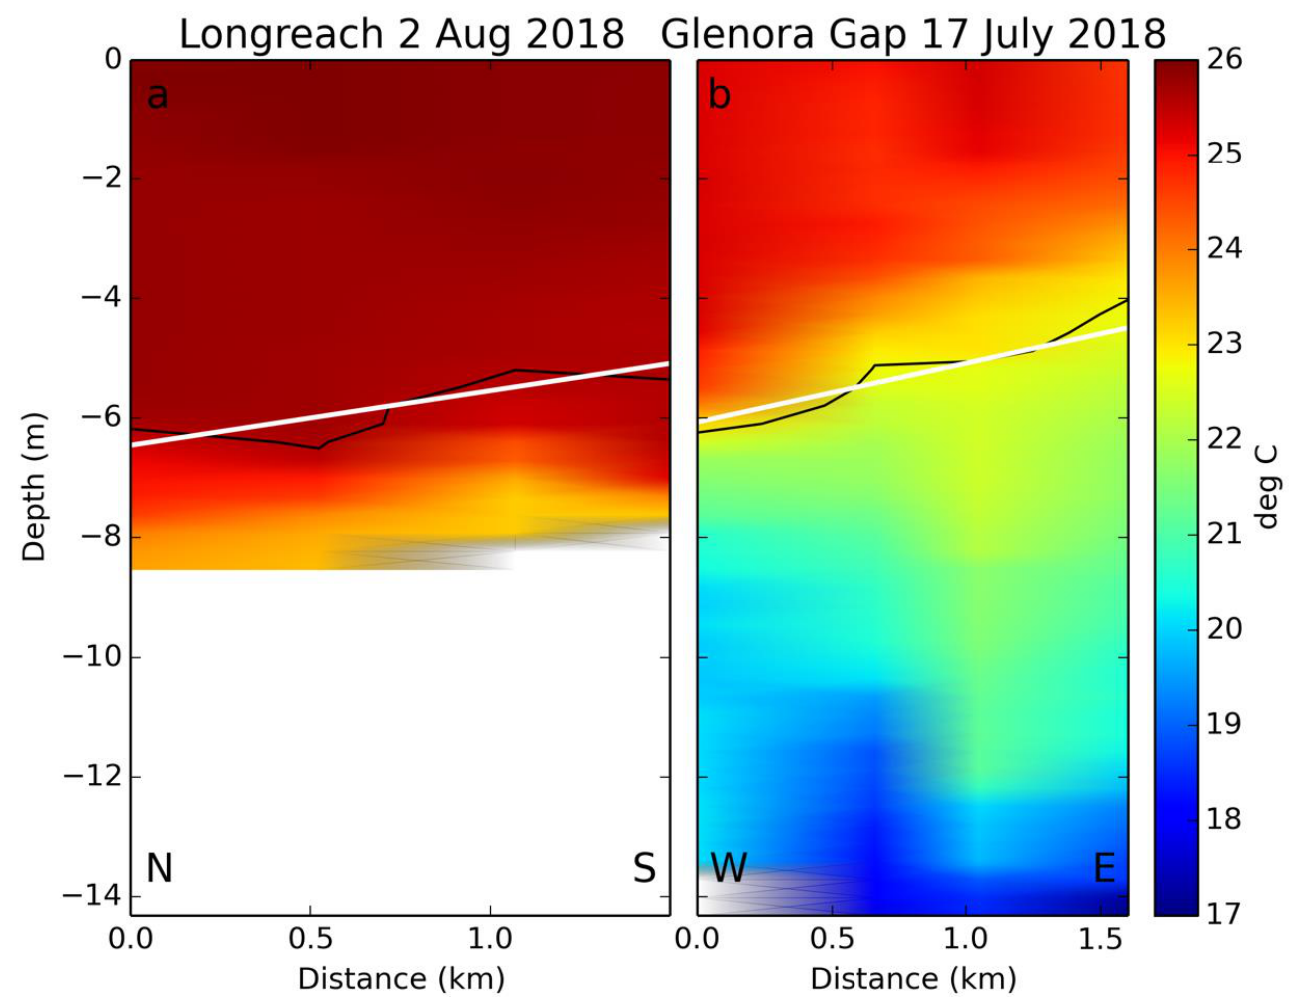
Figure 2. Observed temperature transects in ( a ) Longreach on 2 August 2018 and ( b ) Glenora on 17 July 2018. Temperature contours for 25.6 and 22.8 °C in Longreach and Glenora, respectively, are shown in black. Estimated interface slopes from Equation (3) are shown in white.